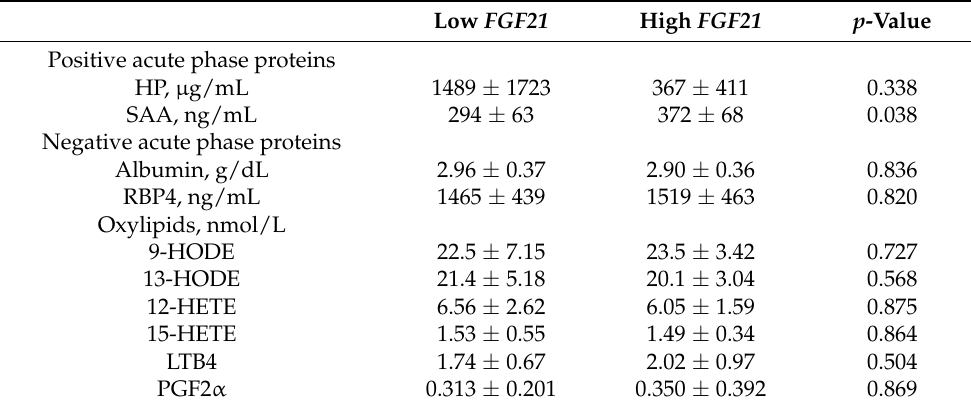
Table 6. Concentrations of positive and negative acute phase proteins and oxylipids in plasma of cows with high and low hepatic FGF21 expression at week 1